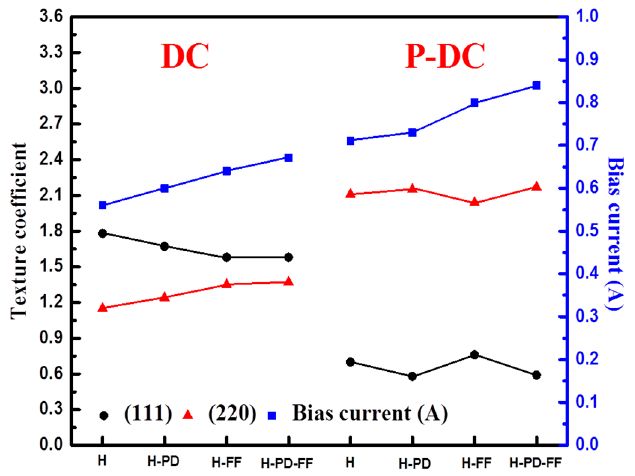
Figure 6. Texture coefficient and I b of samples created using various HiPIMS operating modes under DC or P-DC bias.